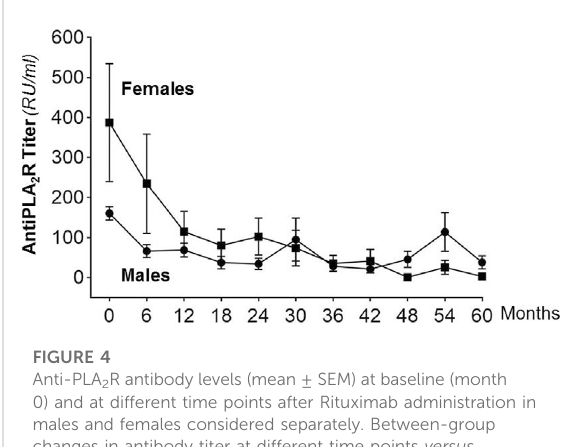
FIGURE 4 Anti-PLA 2 R antibody levels (mean ± SEM) at baseline (month 0) and at different time points after Rituximab administration in males and females considered separately. Between-group changes in antibody titer at different time points versus baseline never differed signi fi